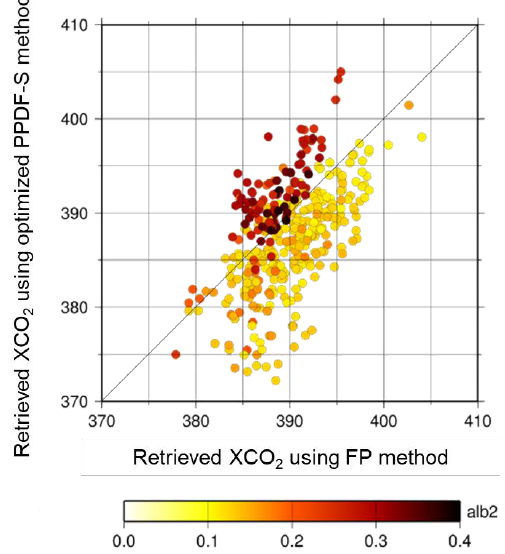
Figure 9. Scatter plot of XCO 2 analyzed by the optimized PPDF-S method and the FP method. The dot color represents the averaged surface albedo in the spectral band of the GOSAT sensor at 1.6 μm.